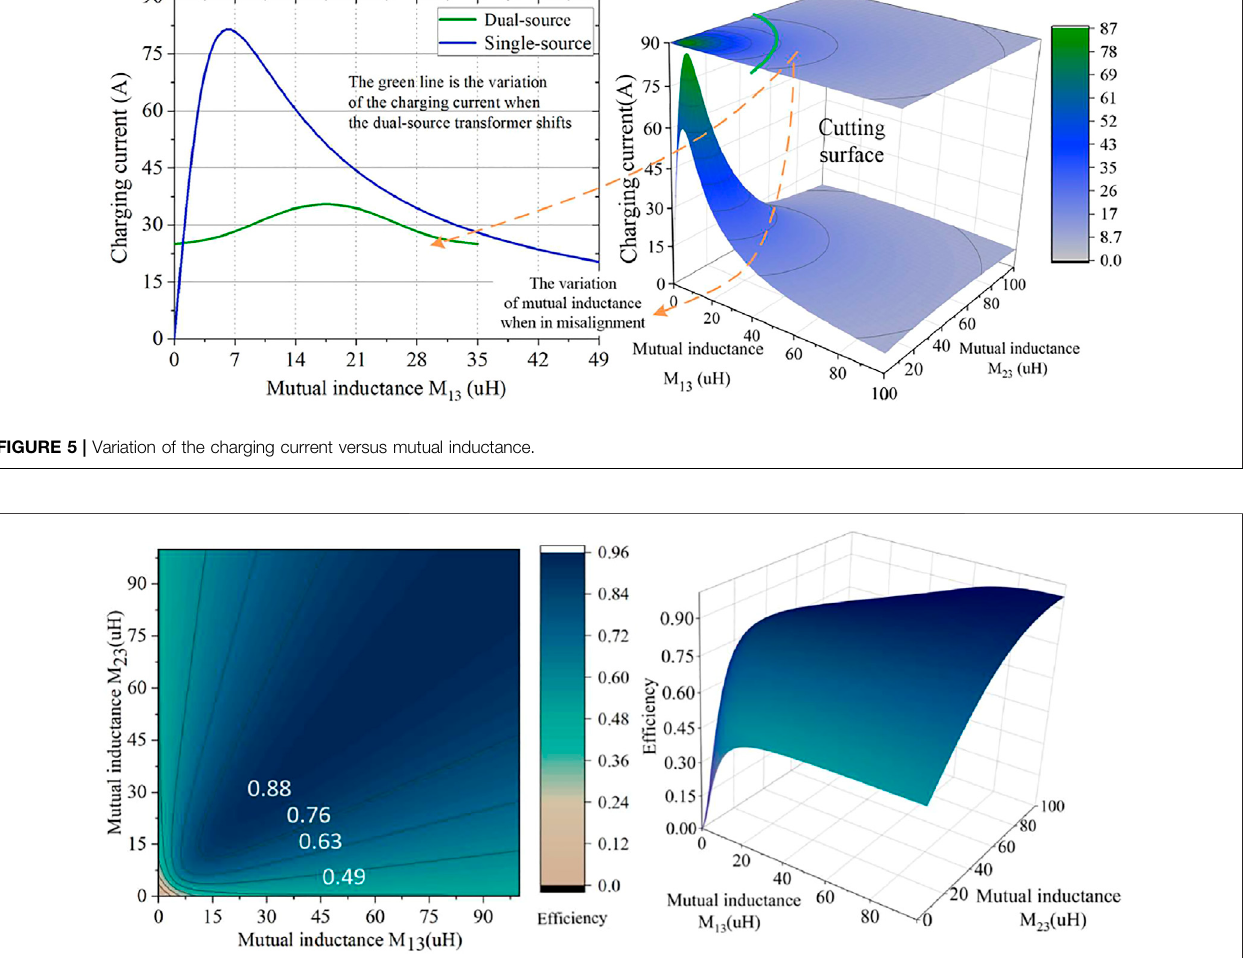
FIGURE 6 | Variation of the ef fi ciency versus mutual